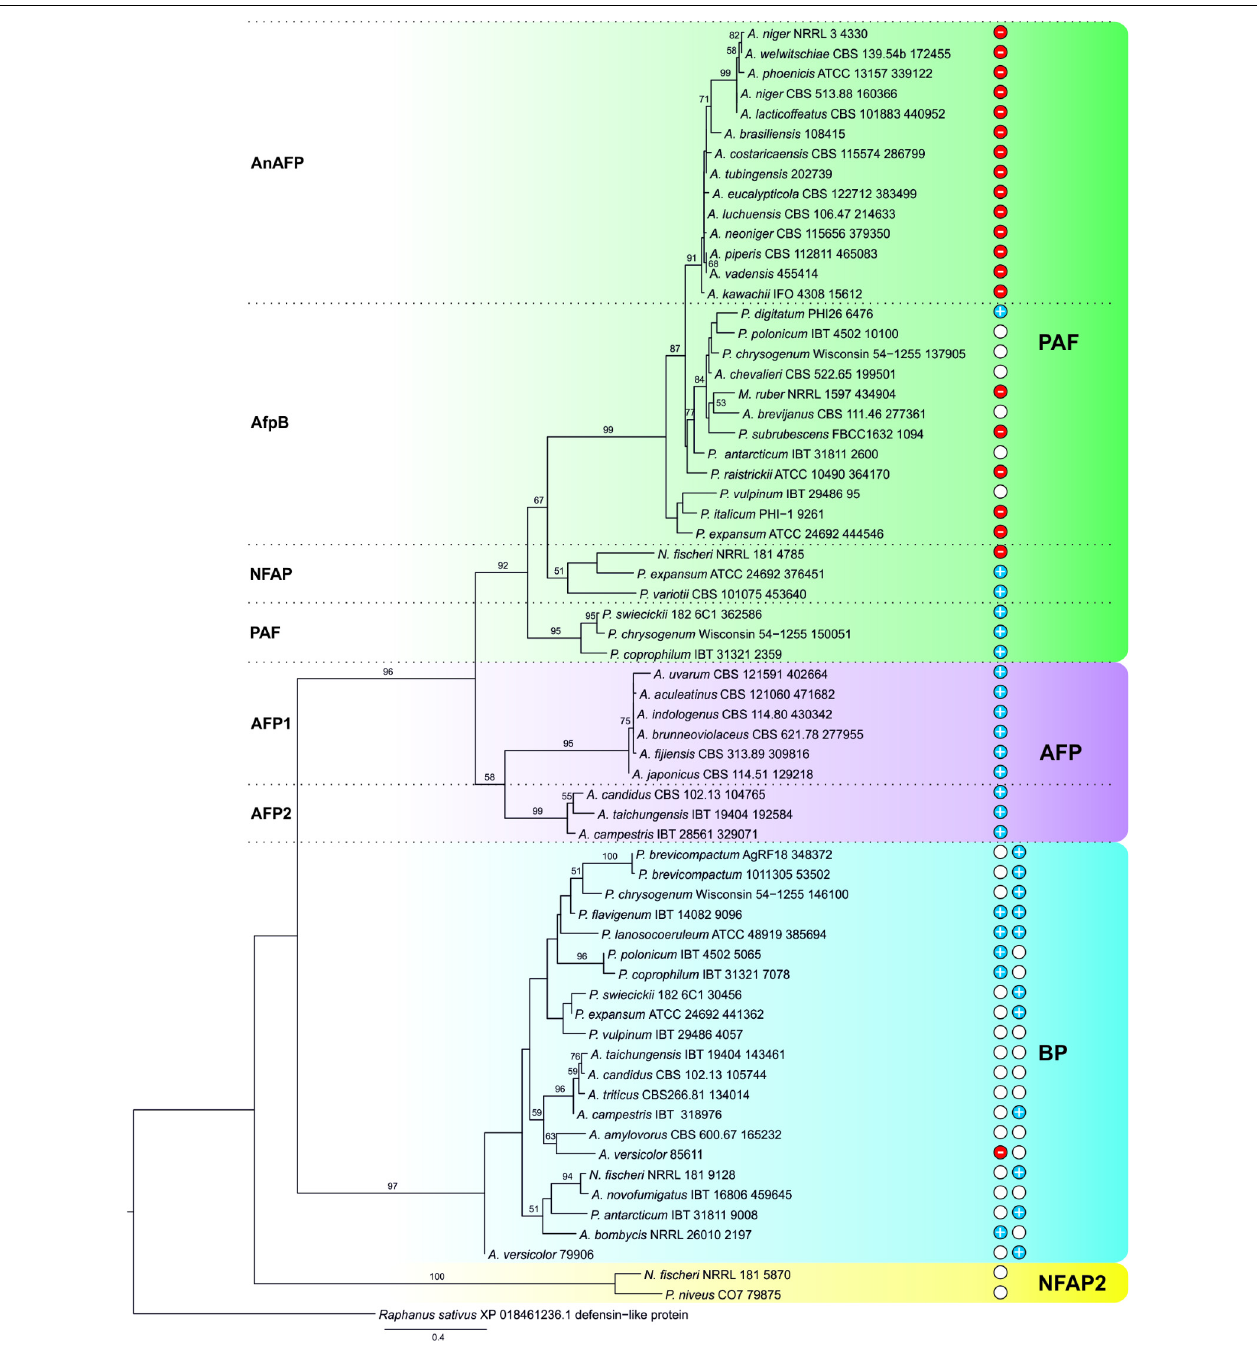
FIGURE 7 | Maximum-likelihood (ML) tree of putative AMPs from Eurotiomycetes. ML bootstrap values > 50% are shown next to branches. The isolate names are given with the accession number of the respective AMP (listed in Supplementary Table S6). The net charge(s) (at pH 7.0) of the γ -core motif(s) are indicated: Blue discs with “+” indicate positive ( ≥ +0.8), red discs with “-” negative ( ≤ –0.9), and white discs the almost neutral (–0.2 to +0.3) γ -cores. After BP proteins the net charge of middle and the C-terminal γ -core is shown from left to right. Proteins belonging to PAF-, AFP, BP-, and NFAP2-clades are in green, lilac, blue, and yellow background,